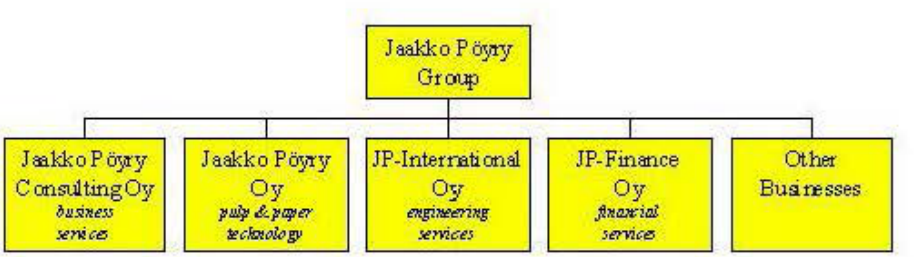
Figure 7. Organizational structure of the .laakko Pi\}'T}' Grnn:p. c. 1~)3